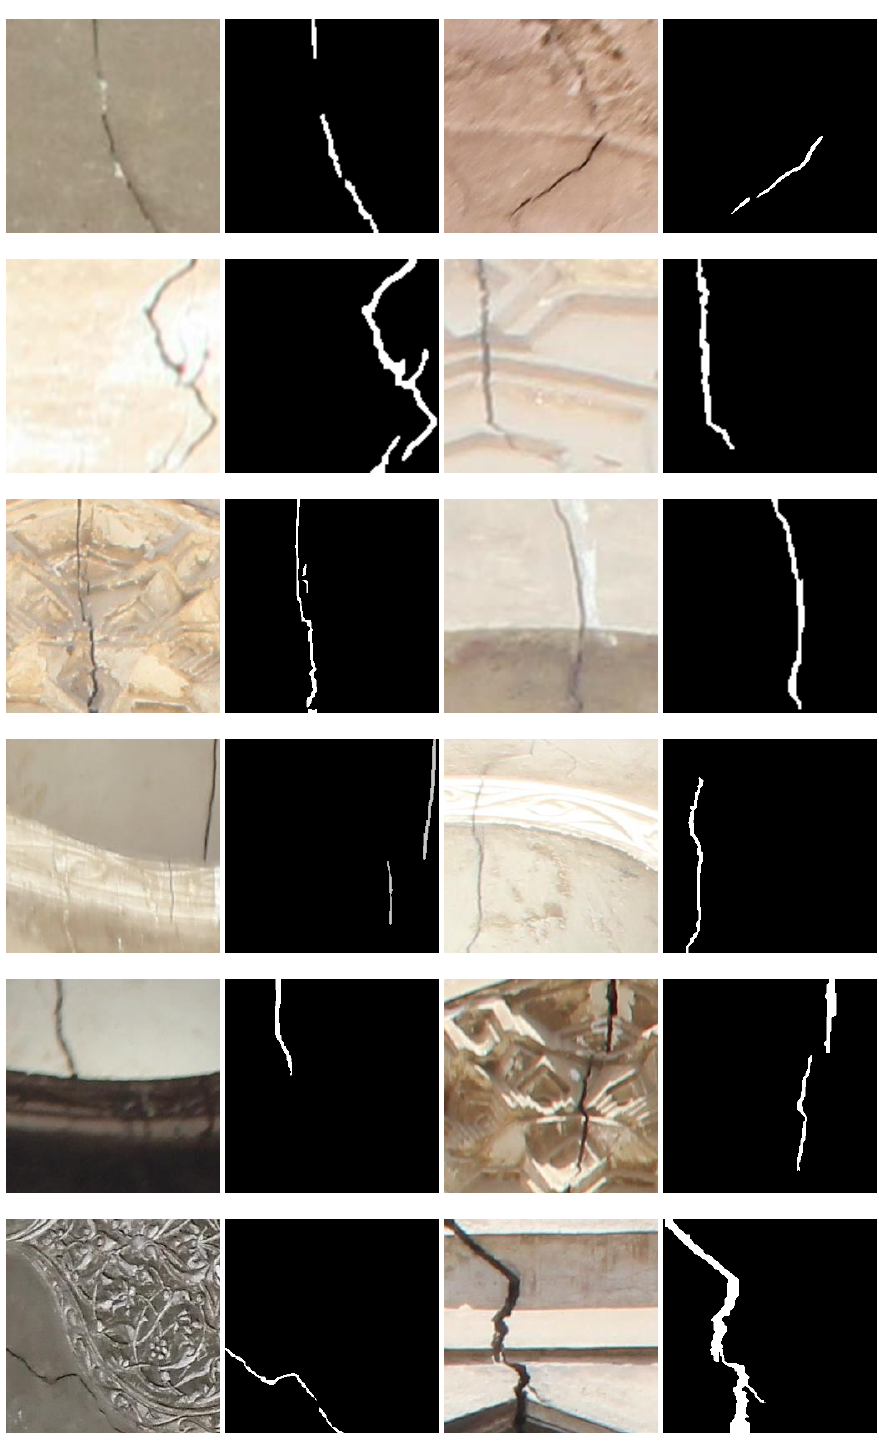
Figure 10. Semi-supervised GrabCut pixel-level map